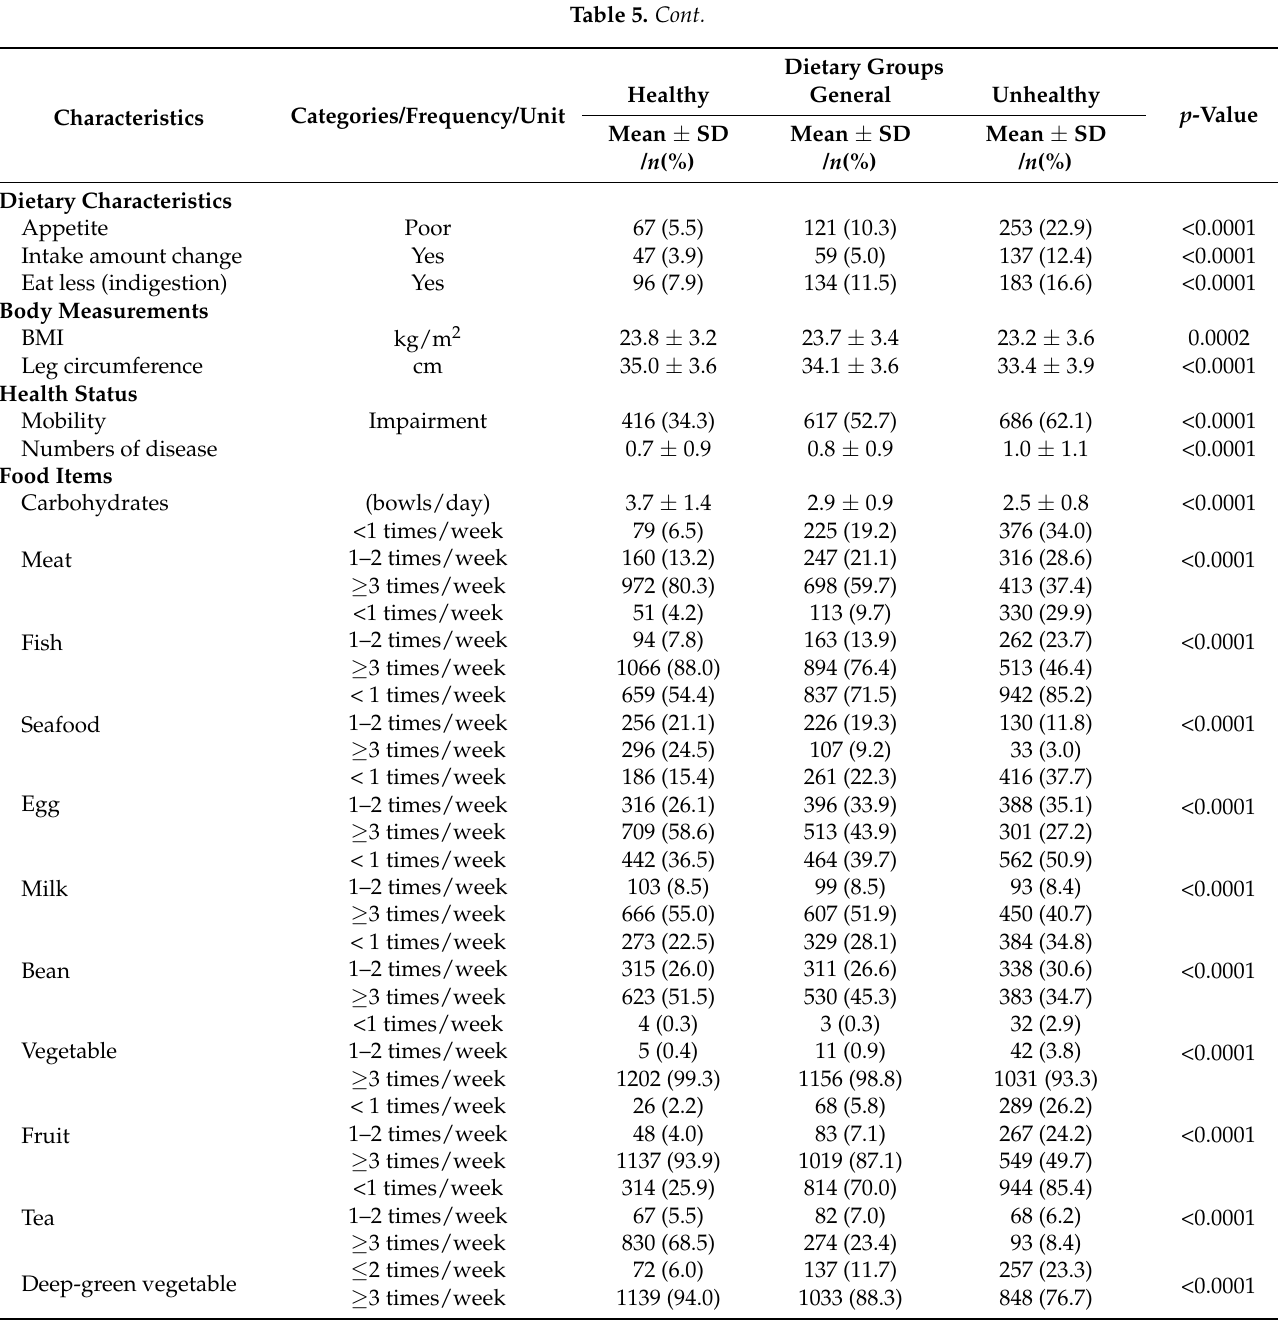
the longitudinal association between dietary patterns and frailty in a community-dwelling older Taiwanese population by using an empirical dietary pattern